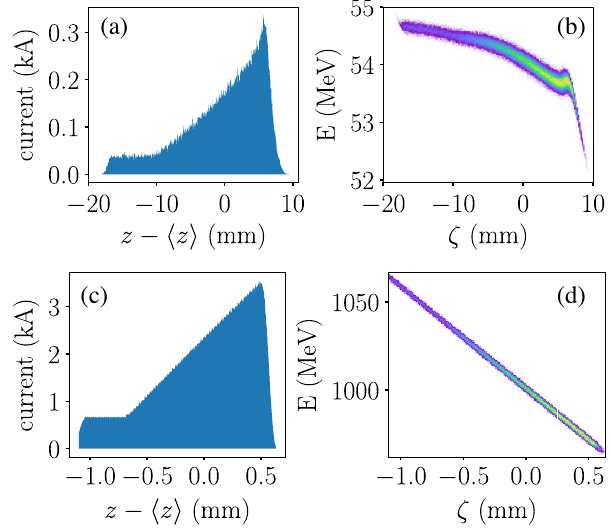
FIG. 4. Current (a) and (c) and LPS (b) and (d) distributions obtained from the backward-tracking optimization (a) and (b) and forward-tracked up BC2 end (c,) and (d) to confirm the agreement with the targeted distribution shown in Fig. 2.